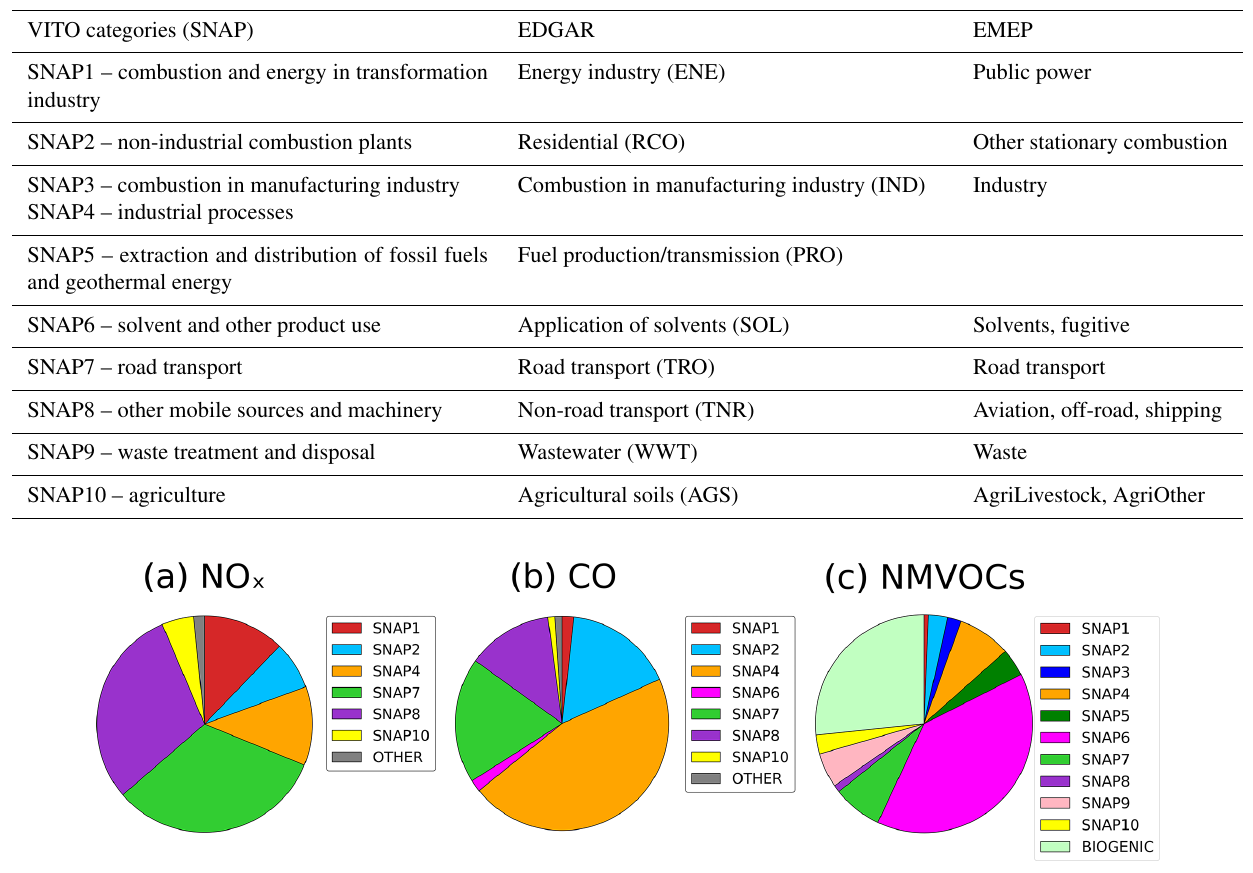
Figure 3. Sector contribution (%) to total emissions for NO x (as NO), NMVOCs, and CO. Sectors with less than 1% contribution are grouped into the “other” category, which differs between